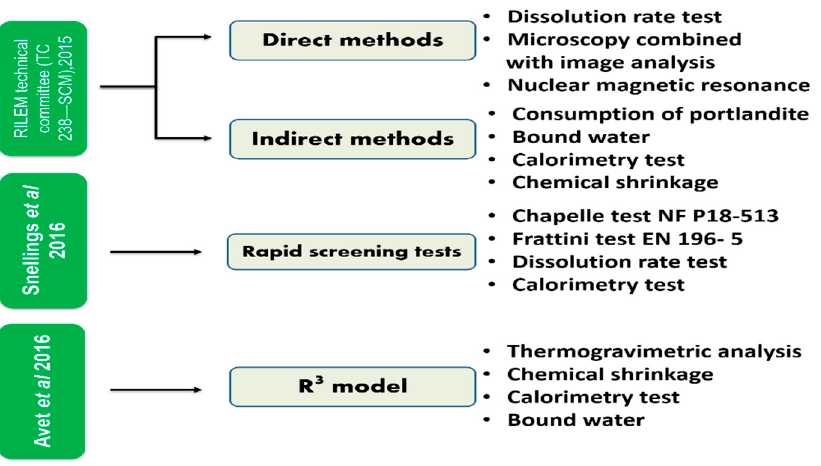
Figure 4. Rapid evaluation methods. Avet et al. [107,113].